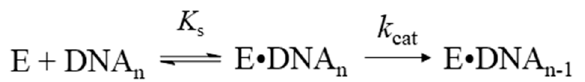
Figure 4. Dependence of the observed rate constant ( k obs ) for the formation of 16–mer product S–1 on enzyme concentration for different substrates. ( A ) Fully complementary substrates. ( B ) Sub- strates containing noncanonical terminal pairs C/A, C/T, and C/C in comparison with C/G. ( C ) Sub- strates FAM Exo–XXX/YYY with a terminal triad of the same nucleotide. ([DNA] = 1 μ M, T = 37°C).